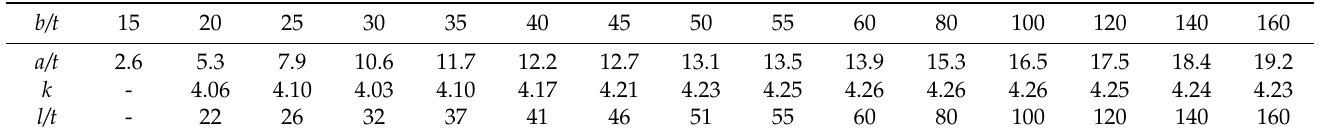
Table 1. a/t , k , and l/t obtained from Equations (2)–(4) and b/t